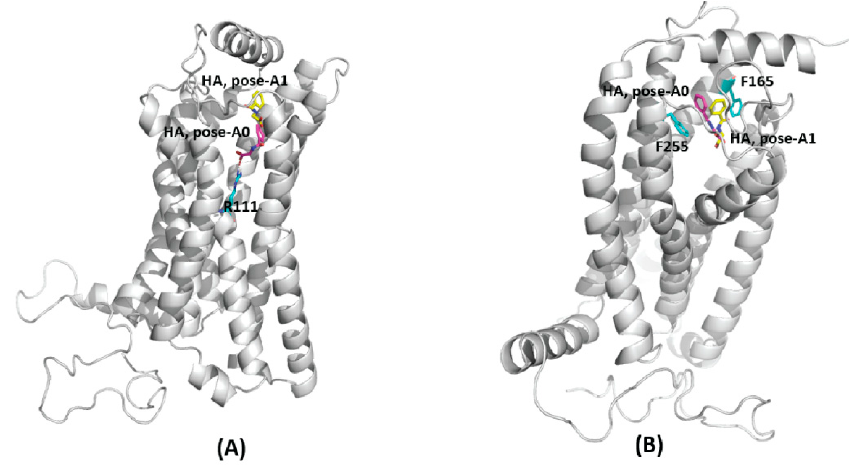
Figure 2. ( A ) Docked structure of GPR109A-HA complex, largest cluster: pose-A0 (purple) and second largest cluster: pose-A1 (yellow). ( B ) Representative structure from the most dominant cluster of GPR109A-HA complex. HA occupies the similar binding site for both the docked poses (pose-A0, purple and pose-A1, yellow) after MD simulation. HA is stacked in between the aromatic rings of F255 and F276.